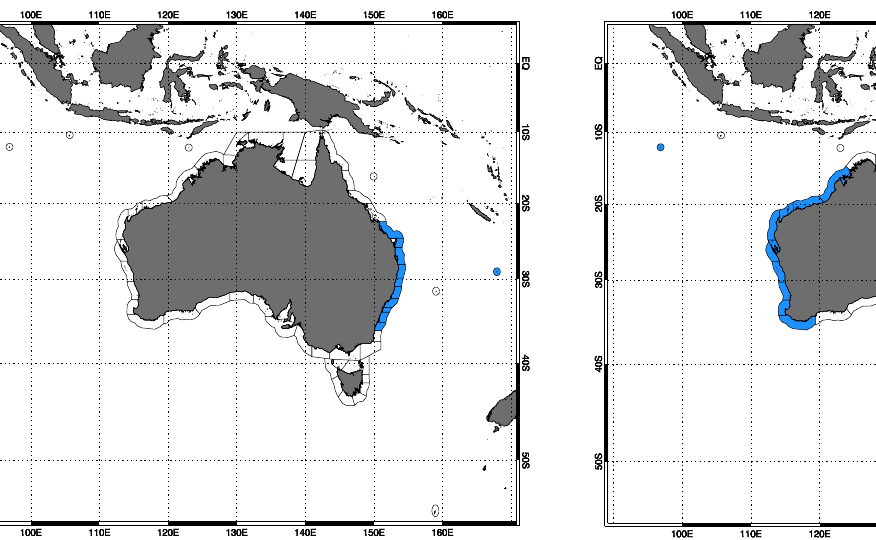
Fig. 9. Derived T2 warnings for the Chile 1960 event based on the thresholds Coastal zones assigned a marine threat are shaded in blue.